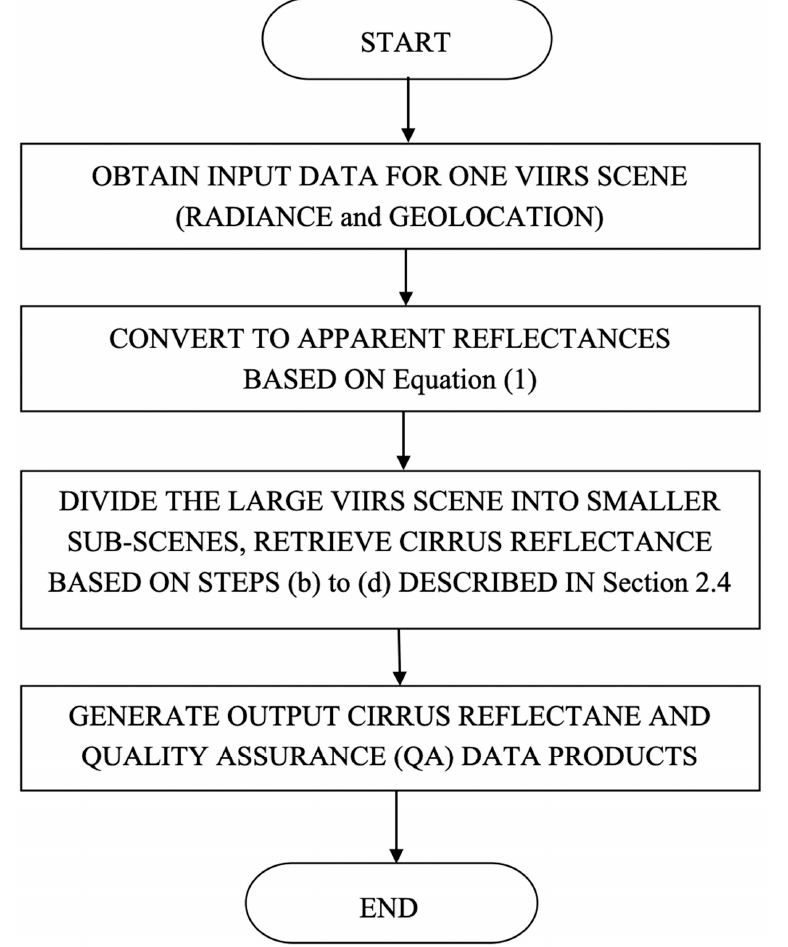
Figure 5. A flow chart describing the implementation of the VIIRS cirrus reflectance